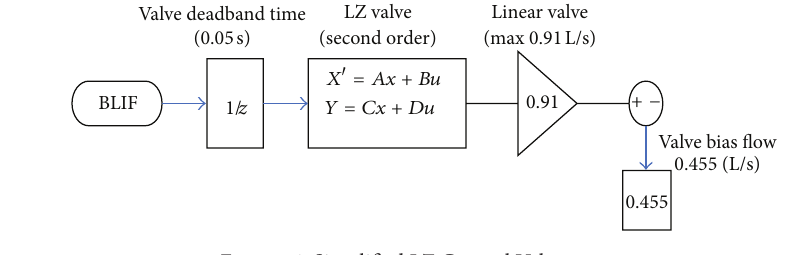
Figure 4: Simplified LZ Control Valve set-up.